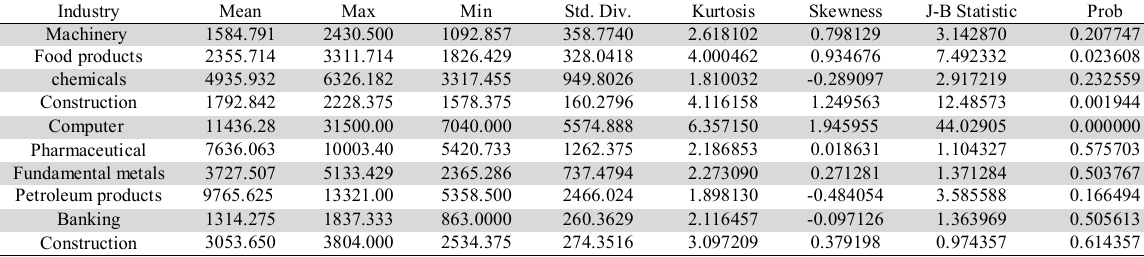
Fig. 2. Three highest and the lowest price volatility industry groups Industry stock price panels descriptive